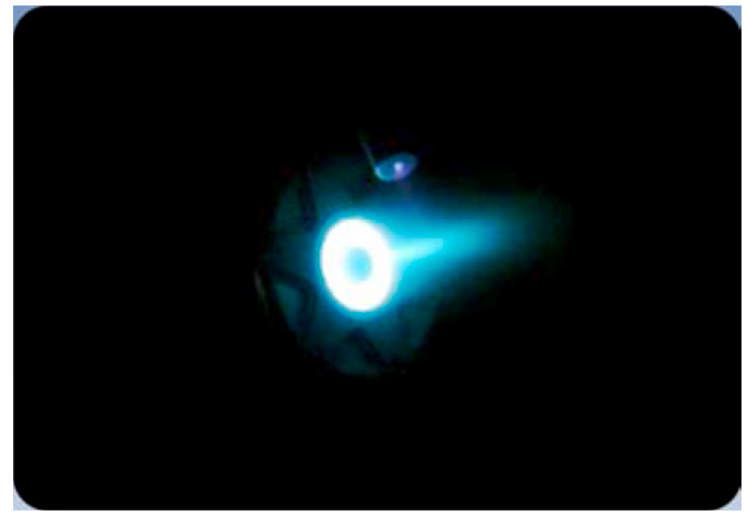
Figure 21. Busek BHT 200 Thruster [36].